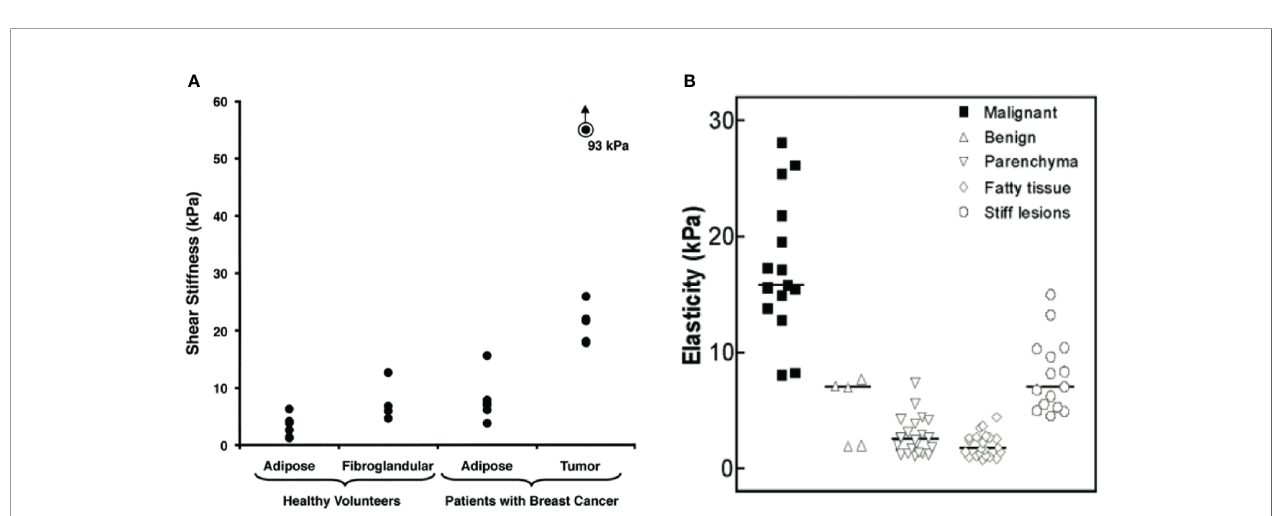
FIGURE 3 | (A) Shear stiffness estimates of different types of breast tissue (mean value). Reproduced with permission from ref. (53), copyright 2002, American Roentgen Ray Society; (B) MRE – based elasticity values for malignant, benign, parenchyma, fatty, and stiff lesions (median). Reproduced with permission from ref. (54), copyright 2002, Georg Thieme Verlag KG.